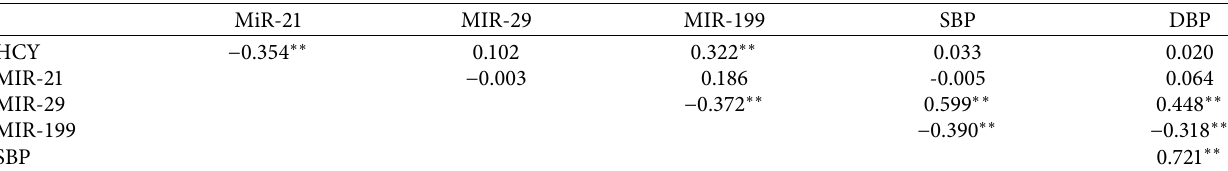
Table 5: Correlation of miR-21, miR-29, and miR-199 with hcy and blood